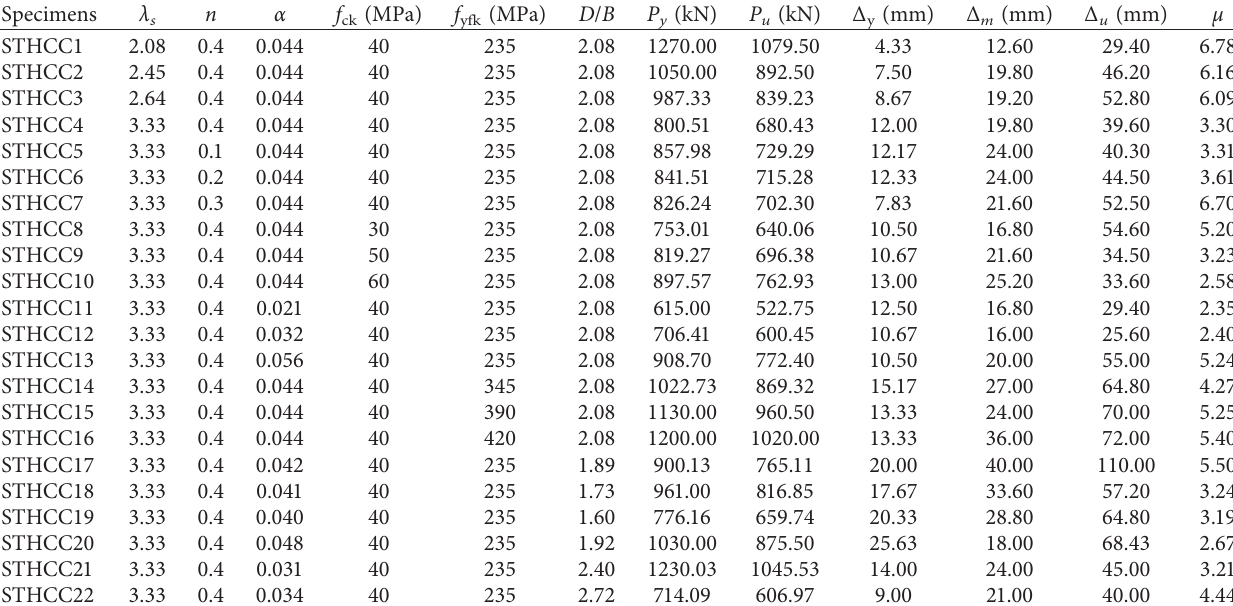
Figure 14: Relationships between K Table 4: Ductility coefficients of STHCC specimens.